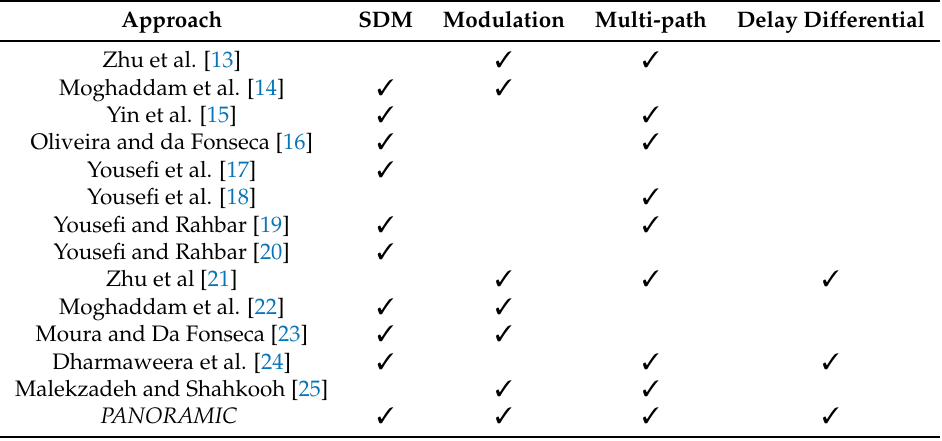
Table 1. Related works comparison with the PANORAMIC